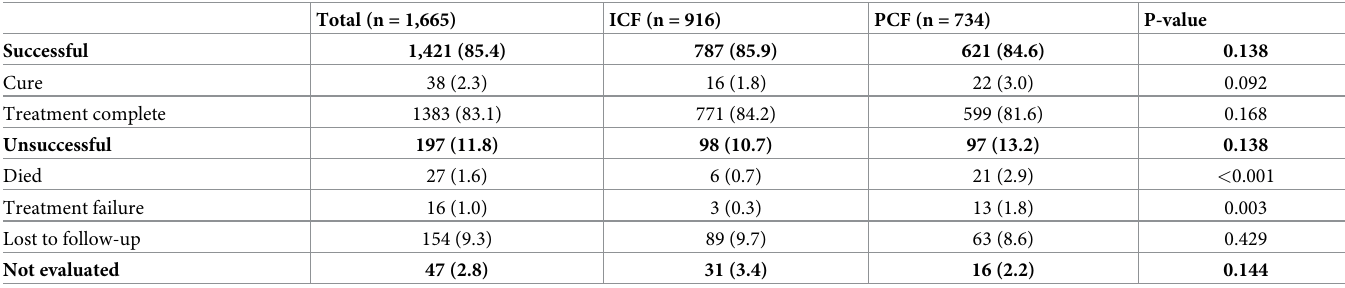
Table 2. Tuberculosis treatment outcomes among children in Karachi, Pakistan, stratified by type of case-finding strategy. Total (n = 1,665) ICF (n = 916) PCF (n = 734)